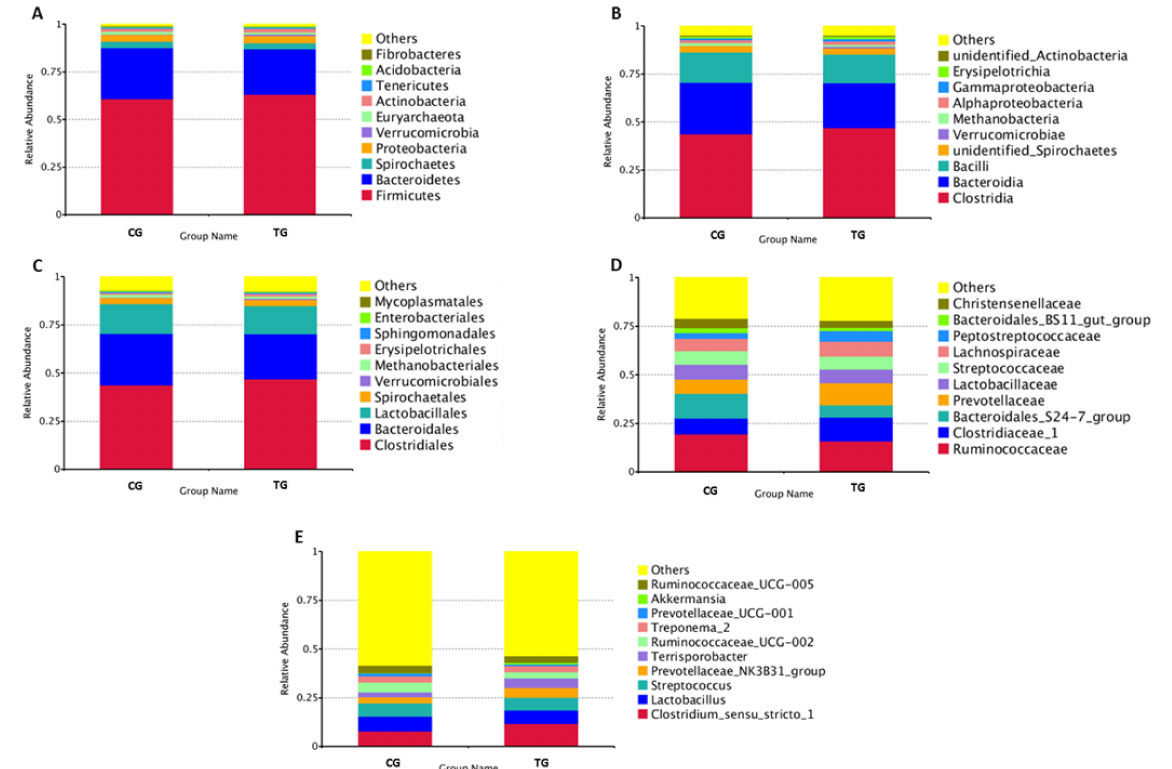
Figure 1. Percent relative abundance of the ten most abundant phyla ( A ), classes ( B ), orders ( C ), families ( D ), and genera ( E ) in the control (CG) and treatment (TG) group.